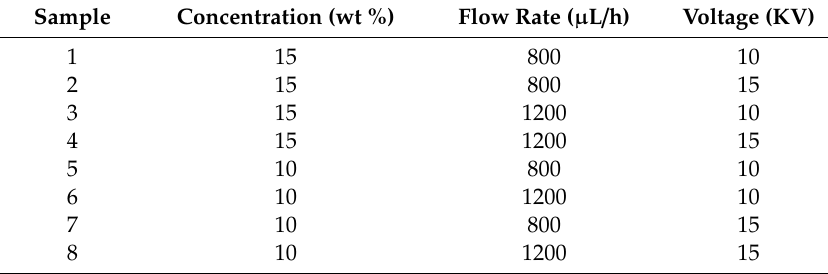
Figure 1. Summary of the operational parameters for the fabrication of the PVC electrospun fibers (polymeric concentration, flow rate, and applied voltage) as well as the output parameters analyzed (fiber diameter, surface roughness, wettability, and corrosion resistance) with their influence by using a design of experiments (DoE). Table 1. Summary of the operational inputs parameters for the fabrication of the electrospun fibers as a function of variable polymeric concentration, flow rate, and applied voltage,